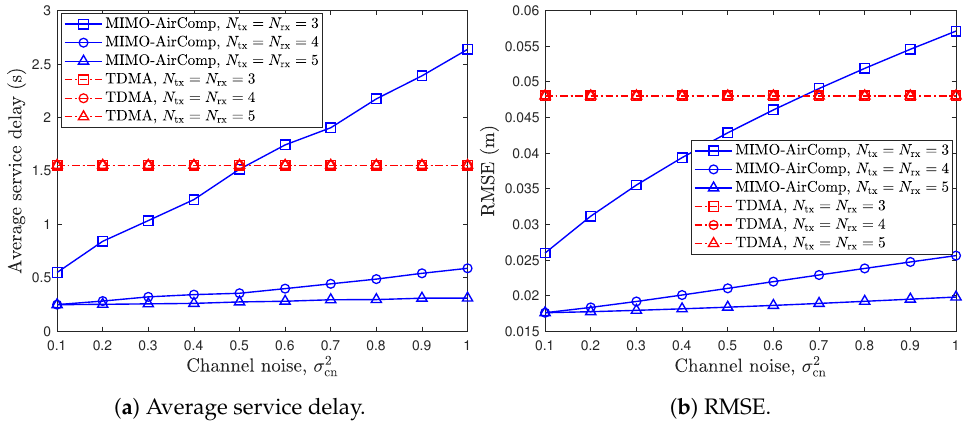
Figure 4. The average service delay and the RMSE of the MIMO-AirComp and TDMA with different N tx = N rx = 3,4,5 for various amounts of channel noise σ 2 cn = 0.1, . . .